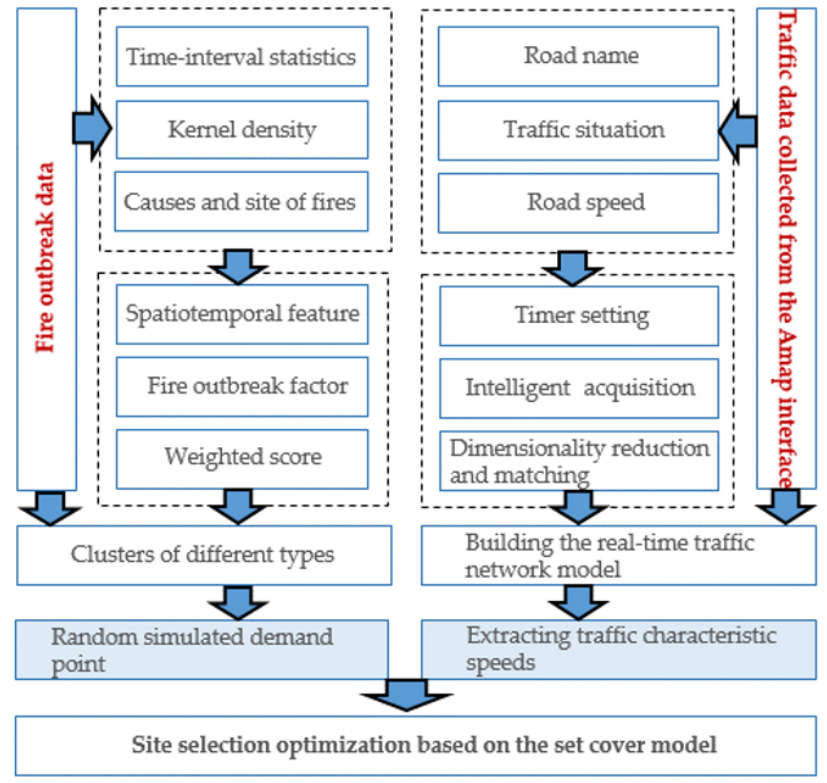
Figure 2. Technical workflow of data